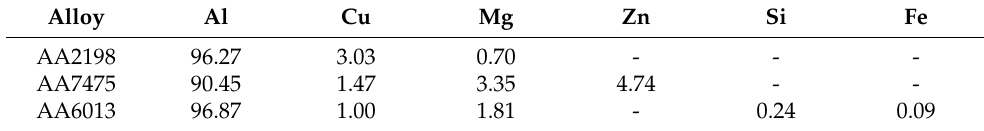
Table 1. Chemical composition of the aluminum sheets used in current